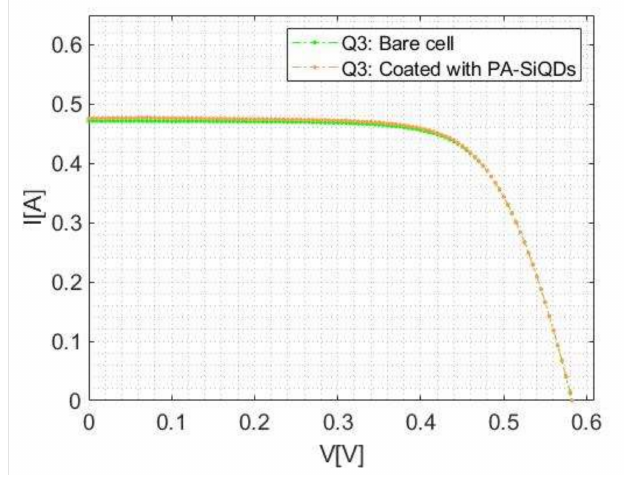
Figure 8. I-V characteristic Q3 sample before (bare cell) and after coated with PA Si-QDs.